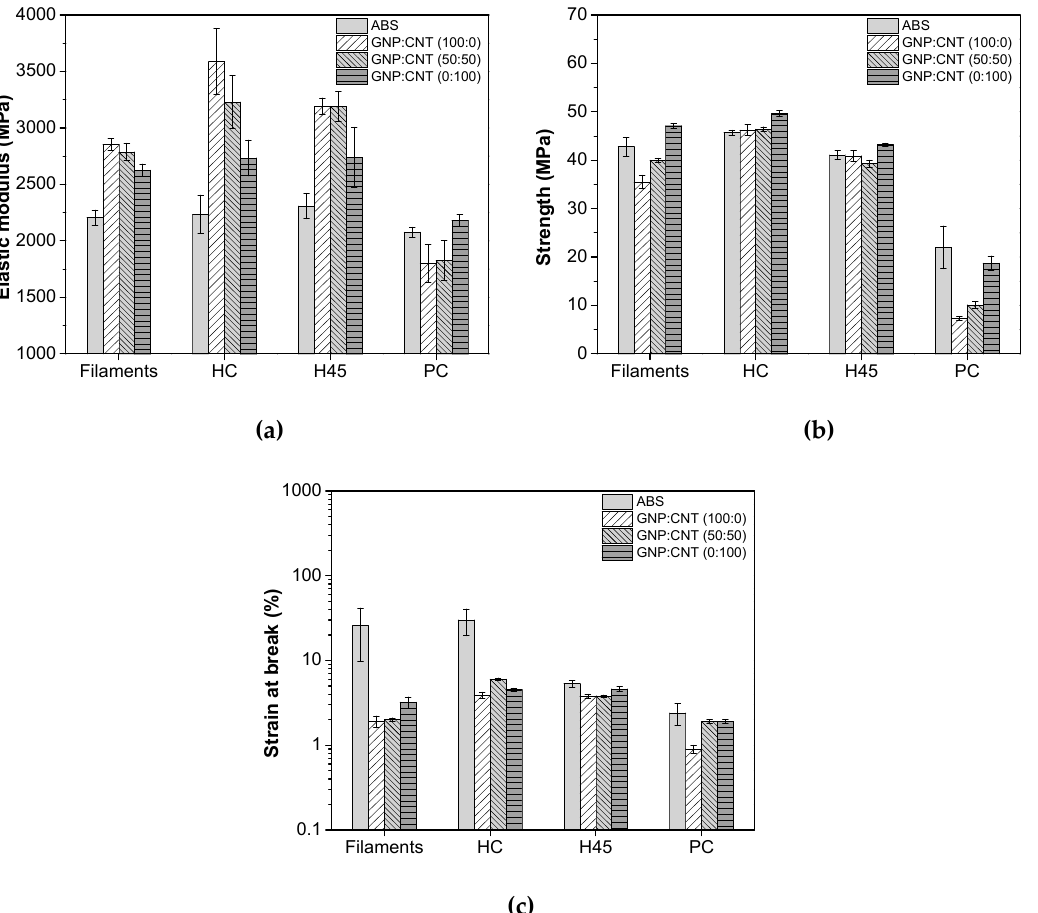
Figure 5. Quasi-static tensile properties of extruded filaments and FFF samples (HC, horizontal 45° angle H45, and perpendicular concentric (PC)) of ABS and its nanocomposite: ( a ) elastic modulus, ( b ) strength, and ( c ) strain at break. Representative stress–strain curves are shown in Figure S1b–e (Supplementary Materials).